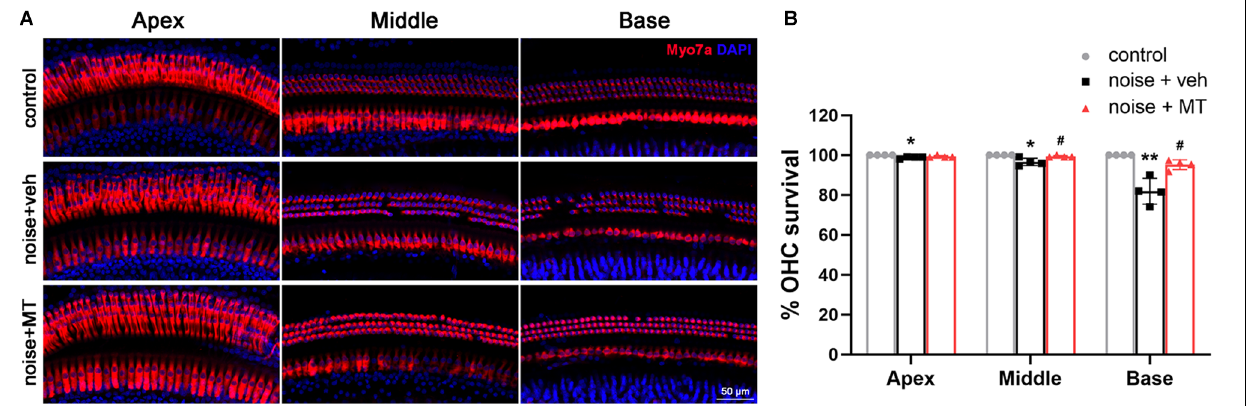
FIGURE 3 | MT treatment prevented noise-induced OHC loss. (A) Representative images of the apex, middle and base turn region of cochlear surface preparations 14 days after the noise exposure. HCs were indicated by Myosin VIIa (red) and DAPI (blue) fluorescent staining. (B) Quantification analysis of OHC survival in the apex, middle and base turn region of the cochlea 14 days after the noise exposure. Data are presented as means ± SD, n = 4 for each group, * p < 0.05 vs. control group, ** p < 0.01 vs. control group, # p < 0.05 vs. vehicle-treated group. OHC, outer hair cell; HCs, hair cells.